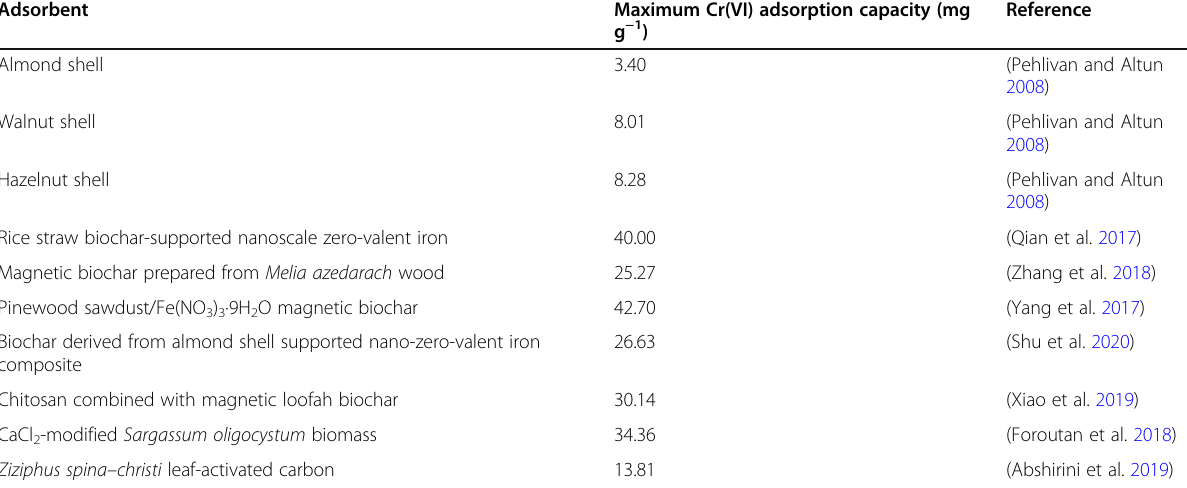
Table 2 The maximum adsorption capacities of Cr(VI) obtained in some similar studies